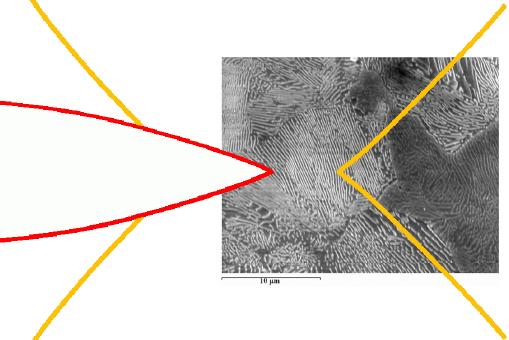
Figura 6: Zona plastificata di fronte all’apice della cricca di fatica propagante attraverso colonie perlitiche a cuore di un blumo di acciaio UNI- EN 1.2738, temprato e rinvenuto. Sono presenti anche limitate zone di austenite residua e bainite modificate dal rinvenimento. Figure 6: Plastic zone in front of the fatigue crack tip at pearlite colonies in the core of a quenched and tempered UNI-EN 1.2738 steel bloom. Small areas of residual austenite and bainite as modified by tempering are also present.